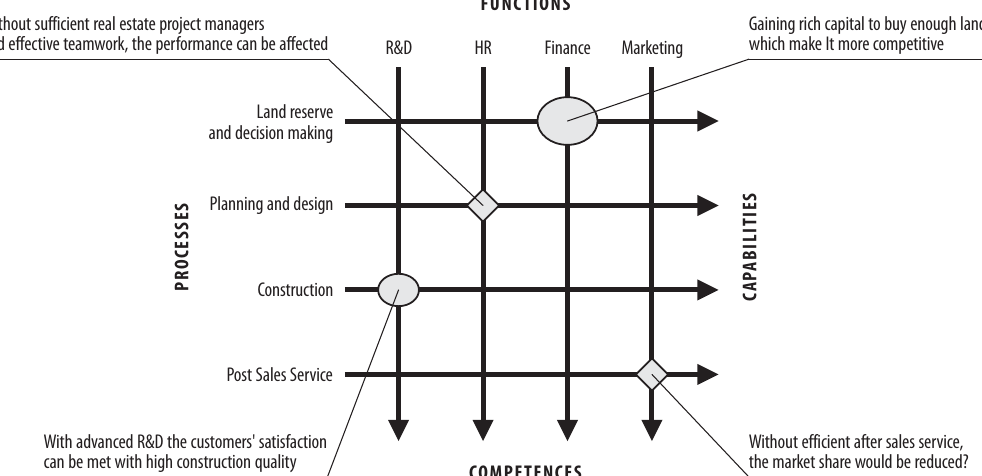
Withoutsufficientrealestateprojectmanagers